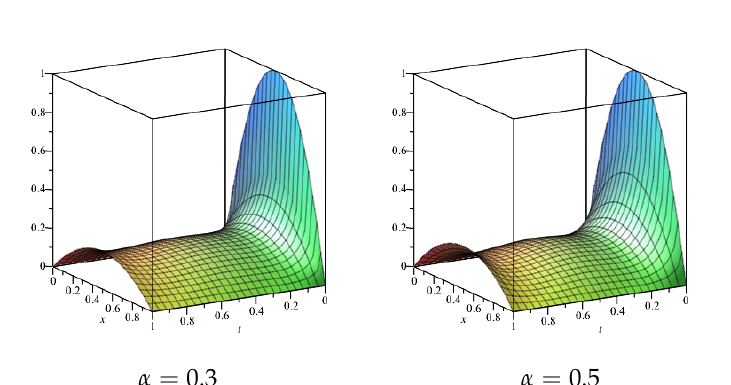
Figure 5. Graphs of solutions for order α = 0.3 and 0.5.